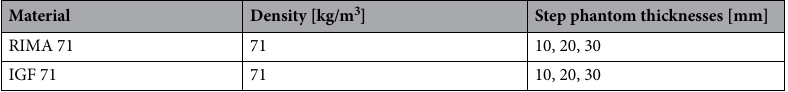
Table 1. Sample materials and corresponding thicknesses of the step phantoms.